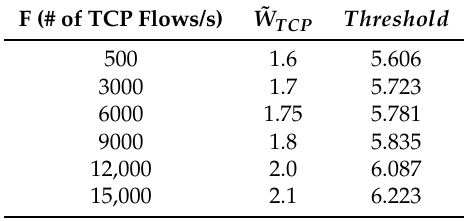
Table 4. Optimized monitoring time window ˜ W TCP for TCP-SYN attack under different traffic scenarios.